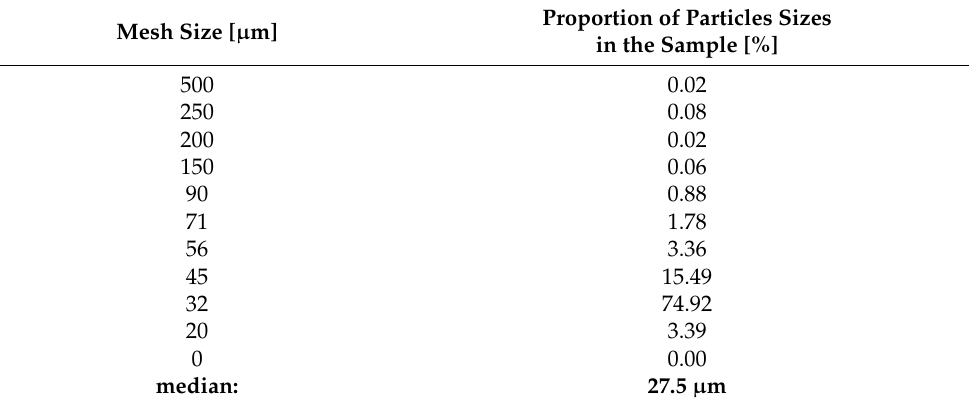
Table 1. Proportion of particle sizes in the sample. Mesh Size [ µ m]